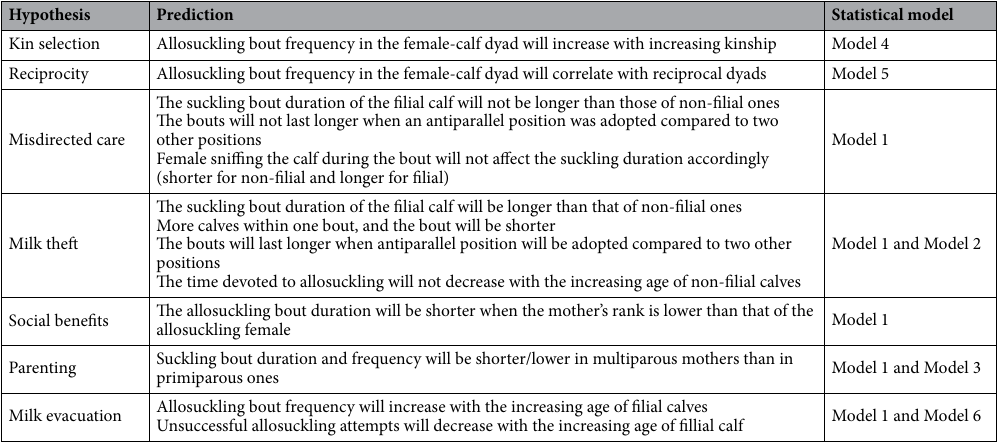
Table 1. Hypotheses and predictions of allosuckling in